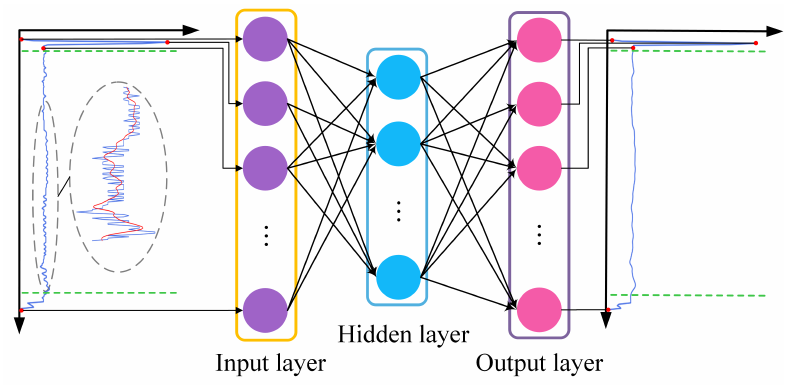
Figure 5. Moving average smoothing denoising